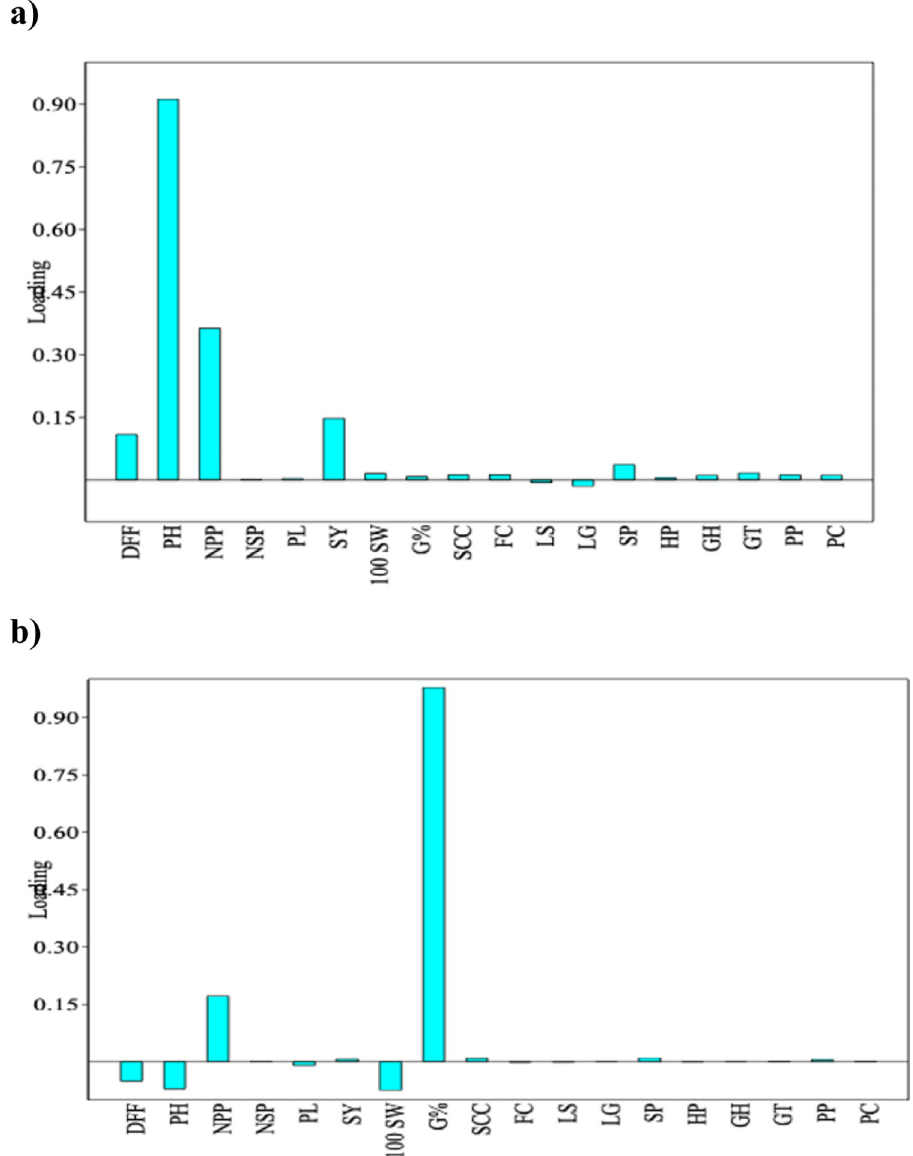
Fig 9. Contribution of quantitative and qualitative traits towards PC 1 (a) and PC 2 (b). DFF: Days to flowering; PH: Plant height; NPP: Number of pods per plant; NSP: Number of seeds per pod; PL: Pod length; SY: Seed yield; 100SW: 100 Seed weight; G%: Seed longevity; SCC: Seed coat colour; FC: Flower colour; LS: Leaf shape; LG: Leaf greenness; SP: Stem pubescence; HP: Hypocotyl anthocyanin pigmentation; GH: Growth habit; GT: Growth type; PP: Pod pubescence; PC: Pod